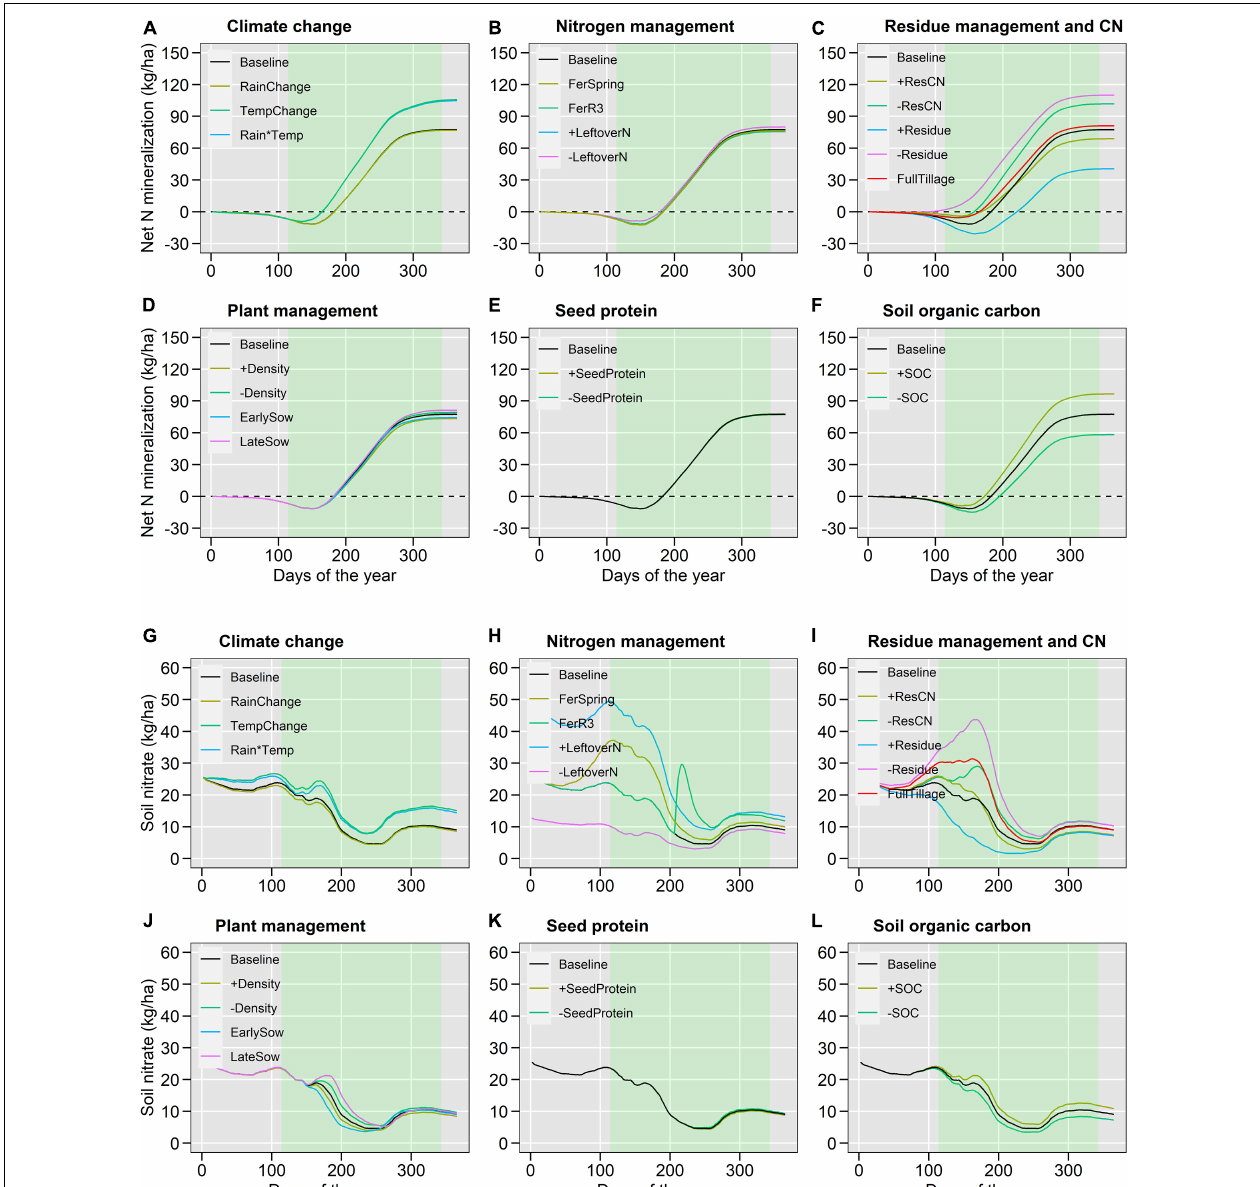
FIGURE 6 | GxExM effects on cumulative net N mineralization (A–F) and soil nitrate at 0–30 cm (G–L) for different scenarios including climate change (A,G) , nitrogen management (B,H) , residue management and quality (C,I) , plant management (D,J) , seed protein (E,K) and soil organic carbon (F,L) . The shaded area represents the average soybean growing period. Values were averaged over 10 locations and 25-years per